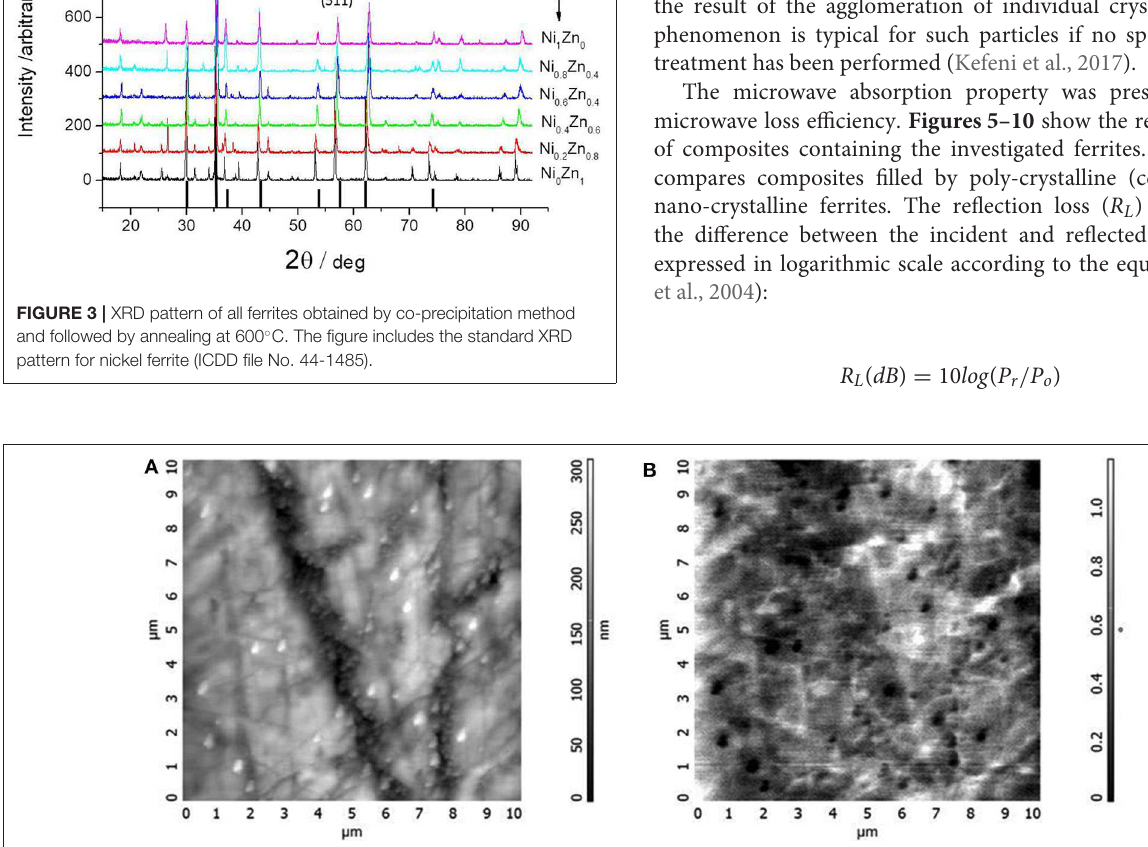
Frontiers in Materials |